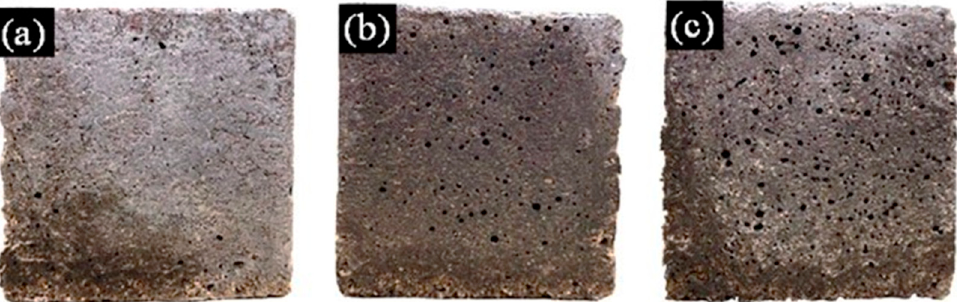
Figure 2. Surface characteristics of ( a ) CON, ( b ) SP-0.5, and ( c ) SP-1.0.